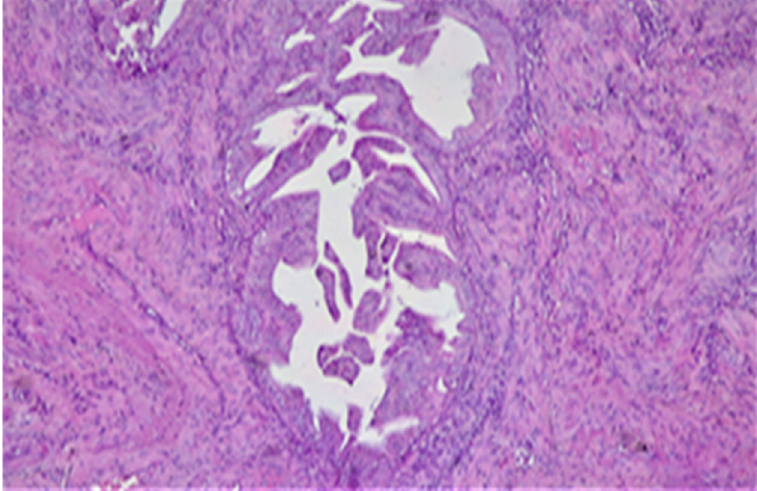
Figure 1. Adenomyosis-like type of invasion—groups of malignant glands invading the myometrium without any surrounding stroma. HE × 10.